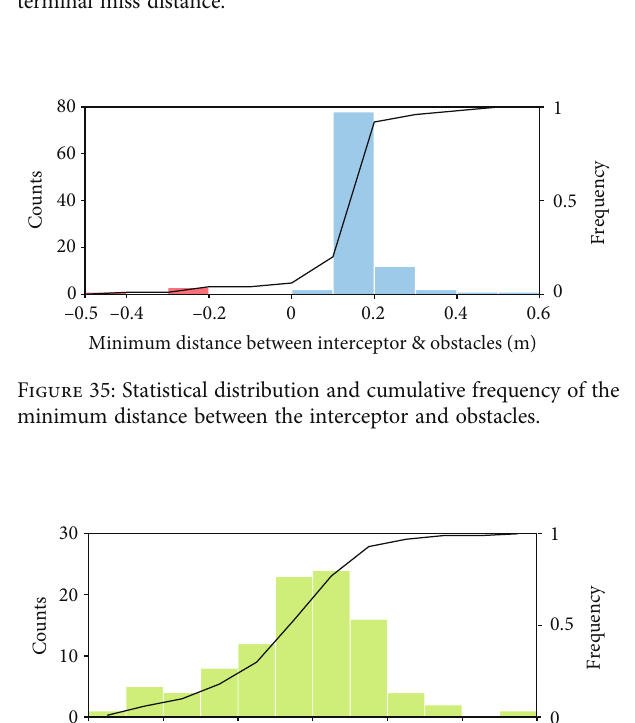
Figure 34: Statistical distribution and cumulative frequency of the terminal miss distance.